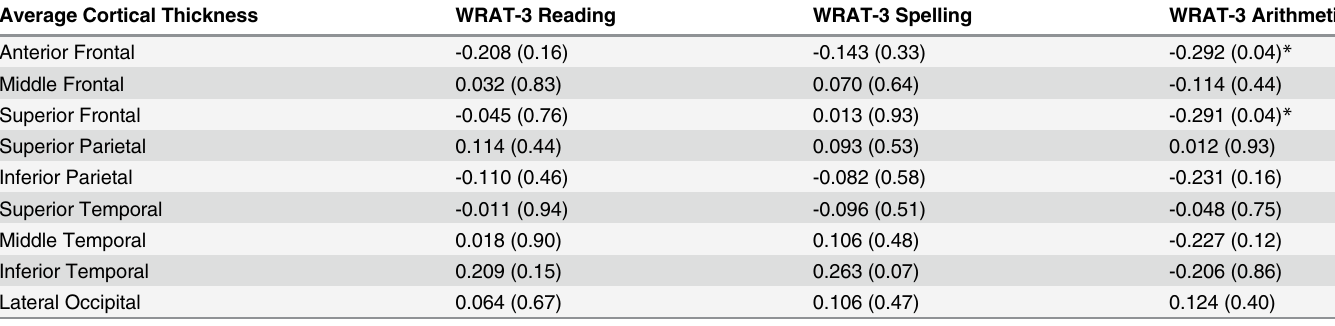
Table 3. Pearson correlations (p-value) between cortical thickness and academic achievement in all